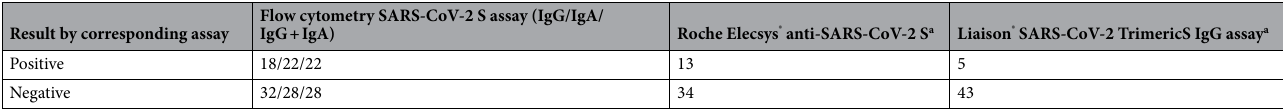
Table 2. Qualitative results returned by Flow cytometry-based and CLIA assay in specimens from RT-PCR- confirmed SARS-CoV-2 infection testing negative by immunoassays in use at the time of specimen collection.